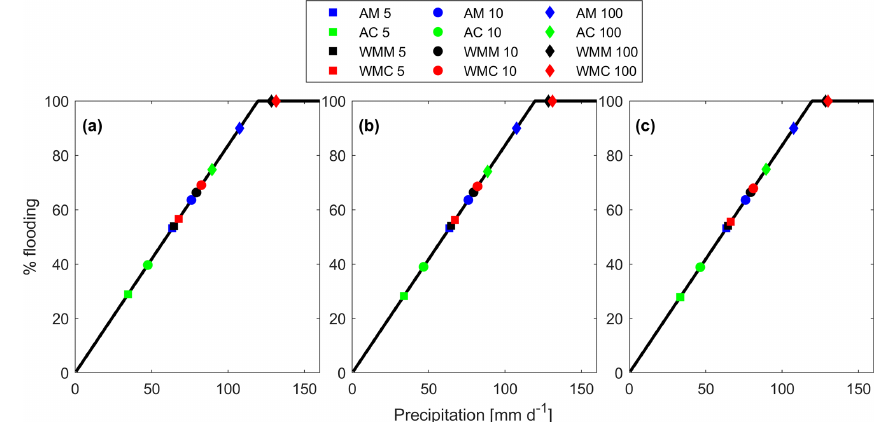
Figure 11. Structural scenario 5- (square), 10- (circle), and 100-year (diamond) return periods for annual maximum (AM; blue), annual coinciding (AC; green), wet-season monthly maximum (WMM; black), and wet-season monthly (WMC; red) data using the (a) Nelsen, (b) Roch–Alegre, and (c) BB1 copulas. Table 9. Precipitation and percent flooding ( (cid:57) ) associated with the 5-, 10-, and 100-year return periods ( T ) using the Nelsen, Roch–Alegre, and BB1 copulas to determine C1 values with annual maximum (AM), annual coinciding (AC), wet-season monthly maximum (WMM), and wet-season monthly coinciding (WMC) samplings. Precipitation values are in millimeters per day, and (cid:57) is a percentage. Values are based off an OWL of ≥ 1.68m, which forces tide valve